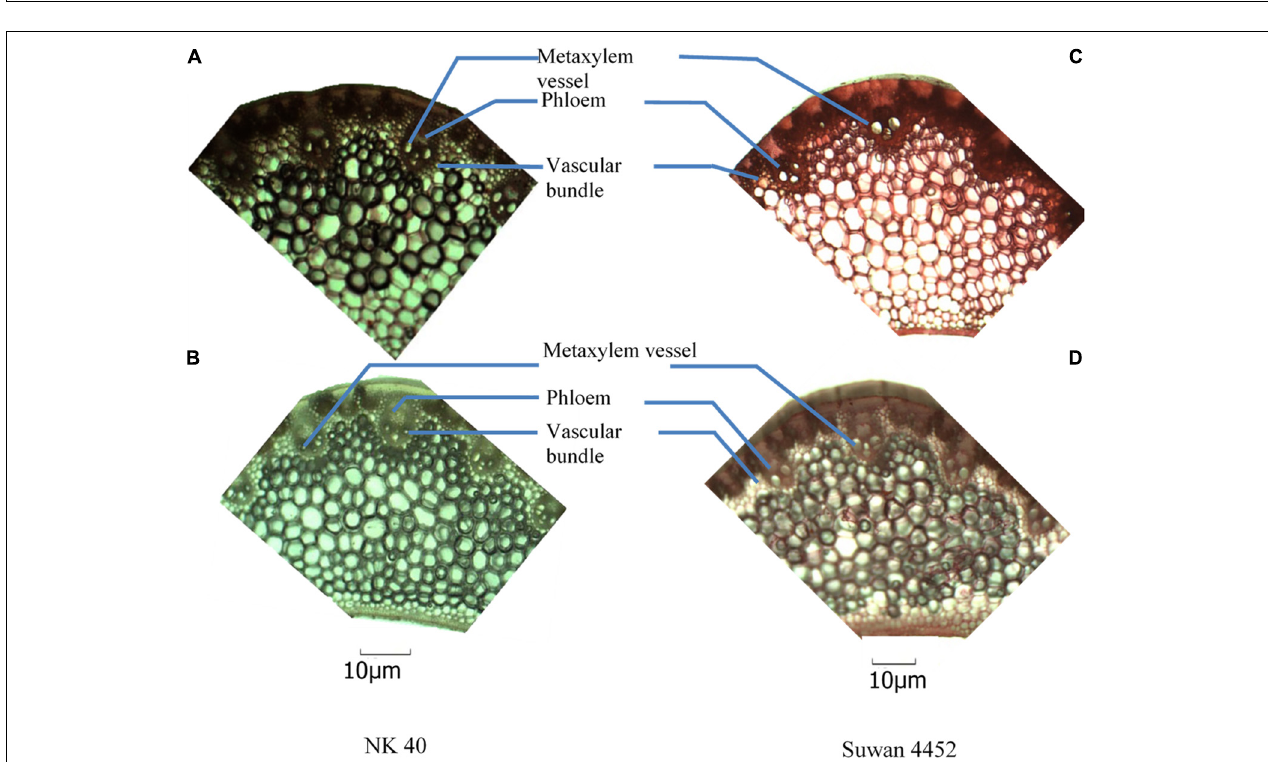
FIGURE 11 | Anatomical view of leaf blade attached to the mid-rib of NK 40 and Suwan 4452 under control (A,C) and water deficit (B,D) during mid grain-filling